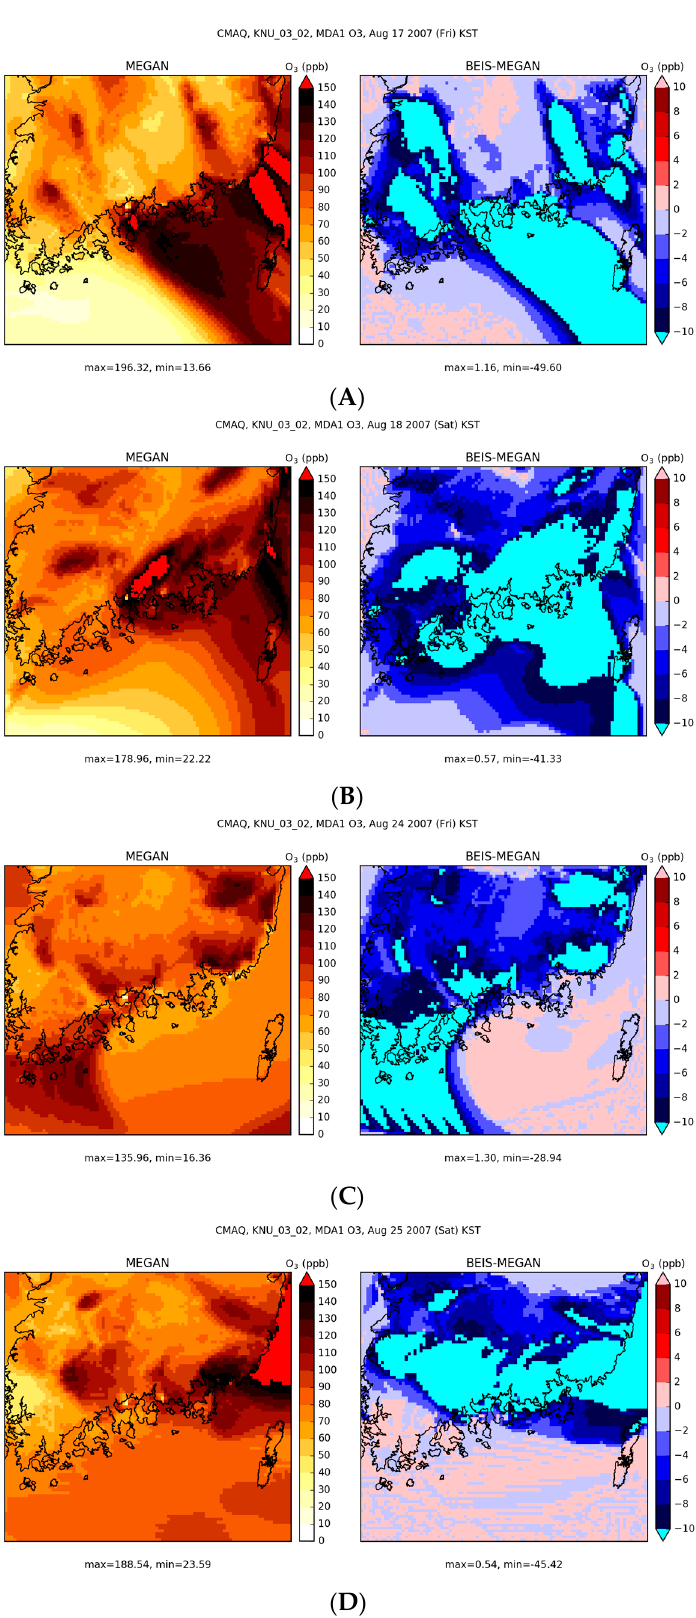
Figure 8. MDA1O3 estimated with CMAQ-MEGAN ( left ) and differences between CMAQ-MEGAN and CMAQ-BEIS3 ( right ): ( A ) 17 August; ( B ) 18 August; ( C ) 24 August; and ( D ) 25 August 2007.